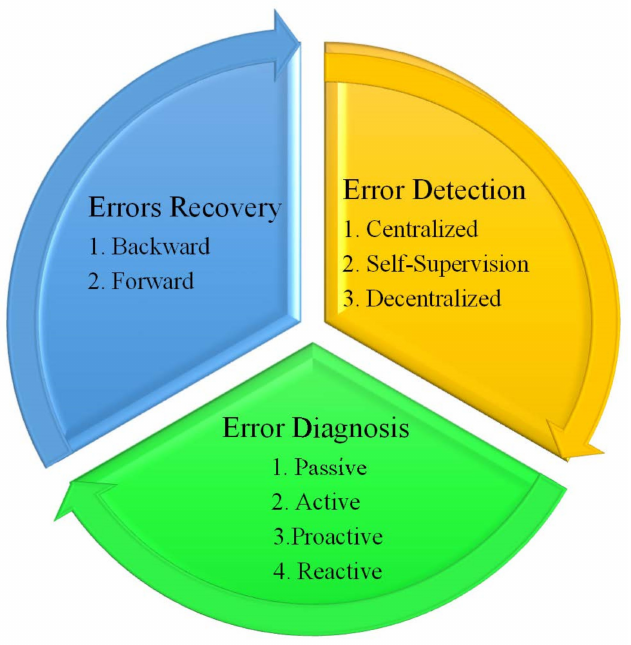
Figure 2. General steps for fault tolerance structure in